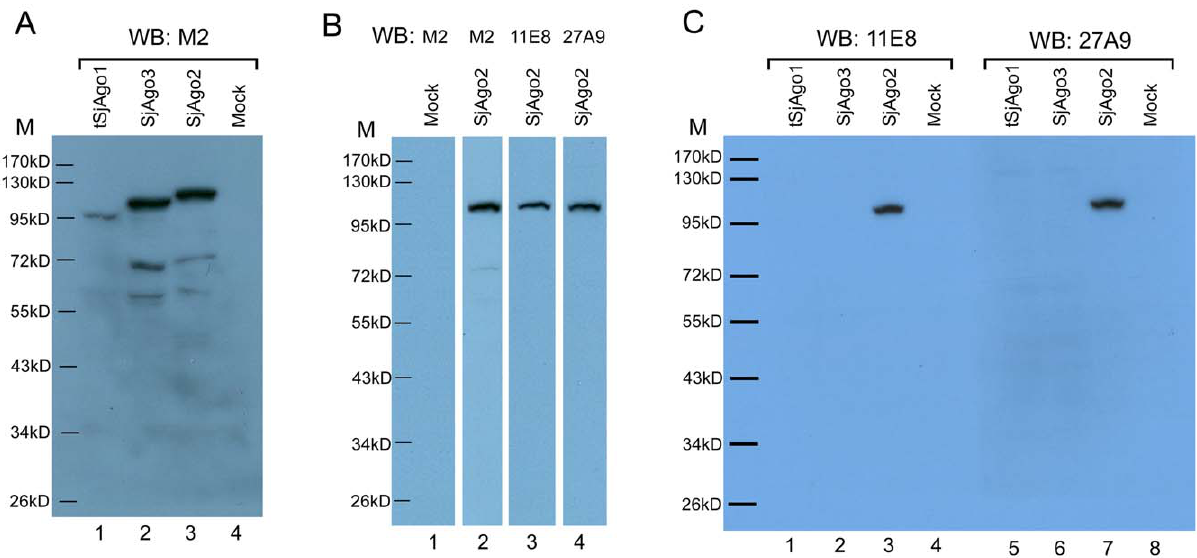
Figure 2. The expression of SjAgo proteins in eukaryotic cells and specific recognition by mAbs 11E8 and 27A9 raised against SjAgo2. A. The expression of Flag-tagged S. japonicum Argonaute proteins in 293T cells was detected by Western blot analysis using anti-Flag mAb M2. Lane 1, tSjAgo1 (aa198-1009); lane 2, SjAgo3; lane 3, SjAgo2; lane 4, Mock: Cells transfected with the empty vector. B. Over-expression of SjAgo2 was recognized by mAbs. Lane 1, Mock; lane 2–4, SjAgo2 was recognized by anti-Flag mAb M2, 11E8, and 27A9, respectively. C. Differential recognition of over-expressed SjAgos by mAb 11E8 or 27A9. Left panel, over-expressed SjAgos detected by Western blot with mAb 11E8. Right panel, over-expressed SjAgos detected by Western blot with mAb 27A9. M, prestained protein ladder SM0671.